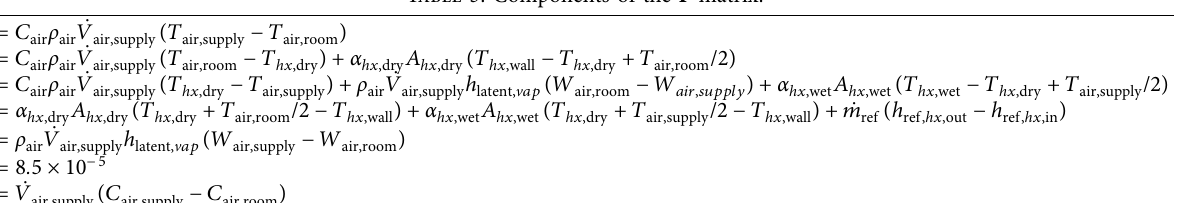
Table 3: Components of the F matrix.